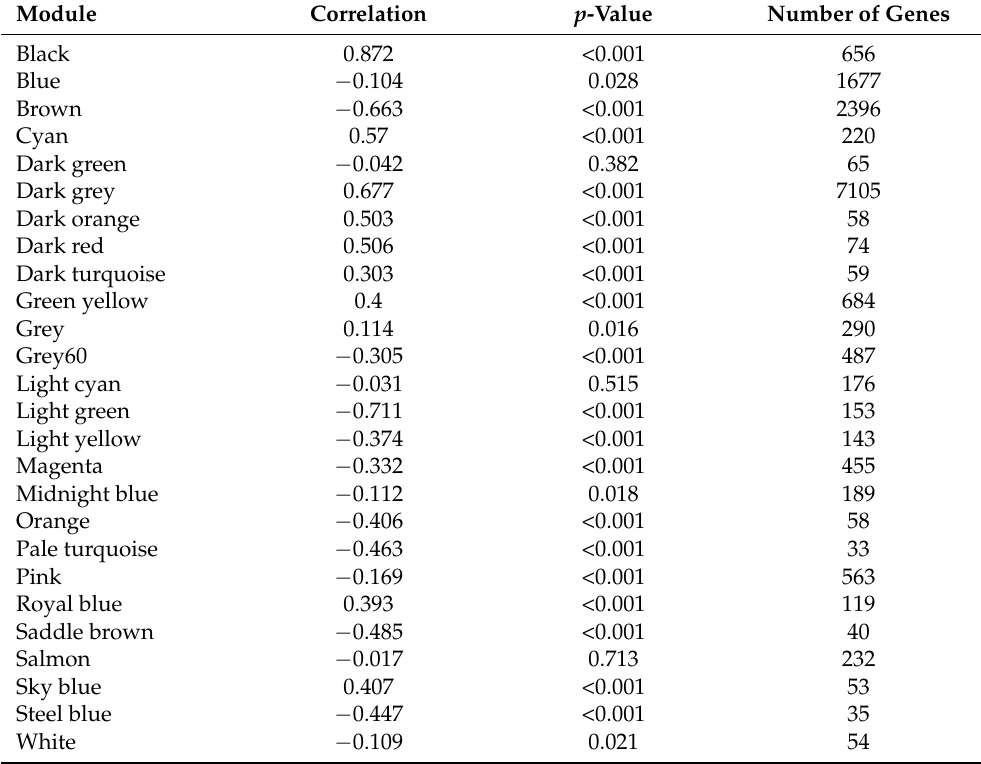
Table 1. Correlation and p -value between each module and liver cancers after weight gene co- expression network